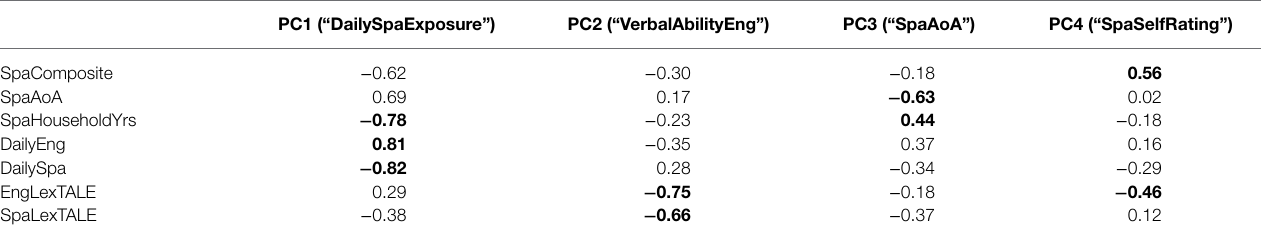
TABLE 6 | Variable loadings for PCs